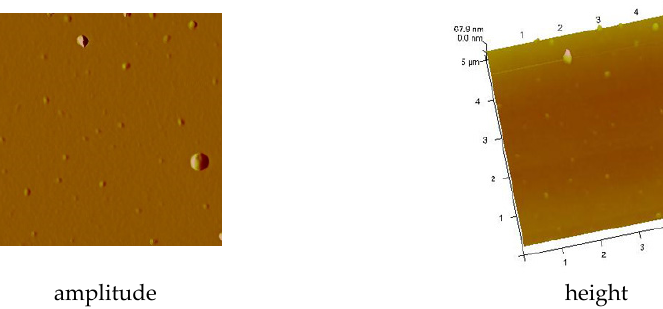
Figure 18. AFM images of [Cu 2 (EtNH 2 ) 2 (µ-O 2 CC 2 F 5 ) 4 ] ( 2 ) /Si, Mag = 5 µm, dip coating before heating.